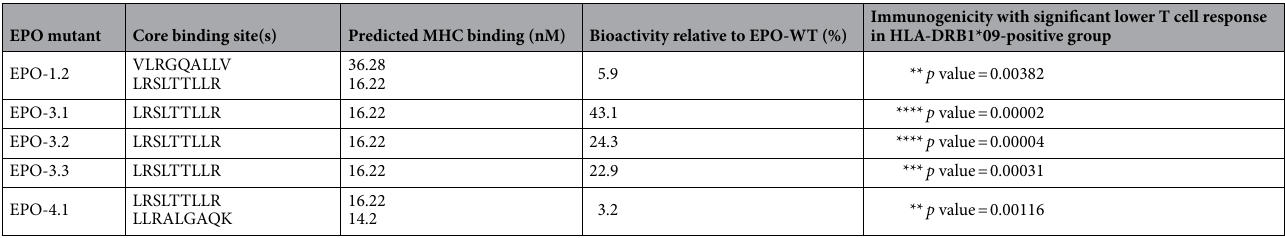
Table 2. A summary of the 5 candidates EPO mutants, their relative effect on immunogenicity, bioactivity and predicted MHC binding.